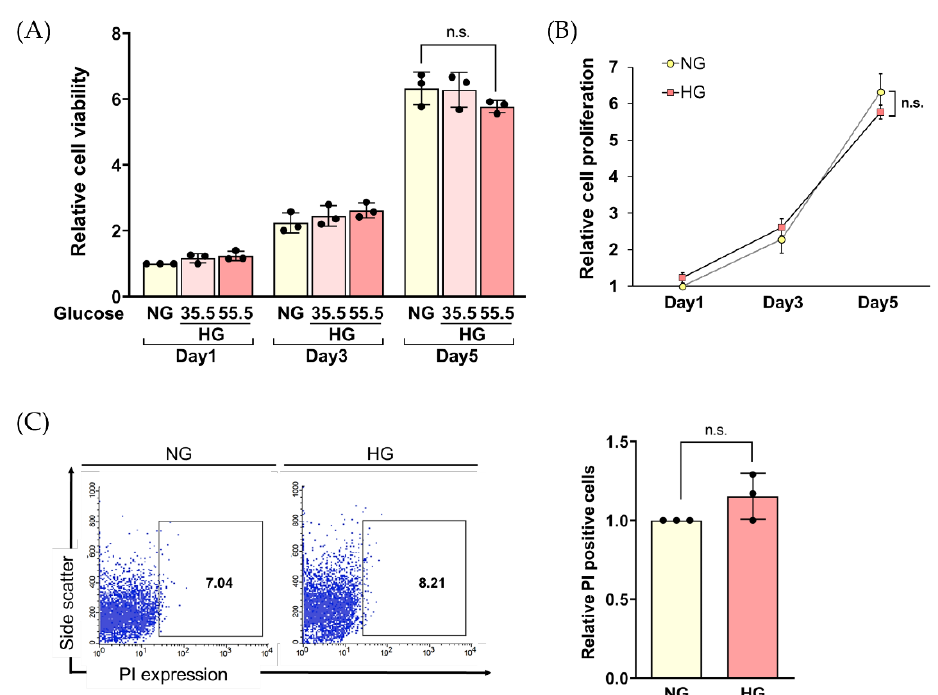
Figure 3. ( A ) The viability of HLE cells treated with changing glucose concentrations was examined for various lengths of time (Day 1, 3, 5) by Alamar blue assay. ( B ) Relative cell proliferation of HLE treated with 55.5 mM glucose at day 5 of incubation was determined by Alamar blue assay. ( C ) Flow cytometry was used to analyze the propidium iodide (PI)-stained cells after treatment with 55.5 mM glucose for 5 days. The relative PI-positive cell is shown in the graph, representing the mean ± SD. Data are representative of three independent experiments. n.s. = not significant, NG = normal glucose, HG = high glucose.